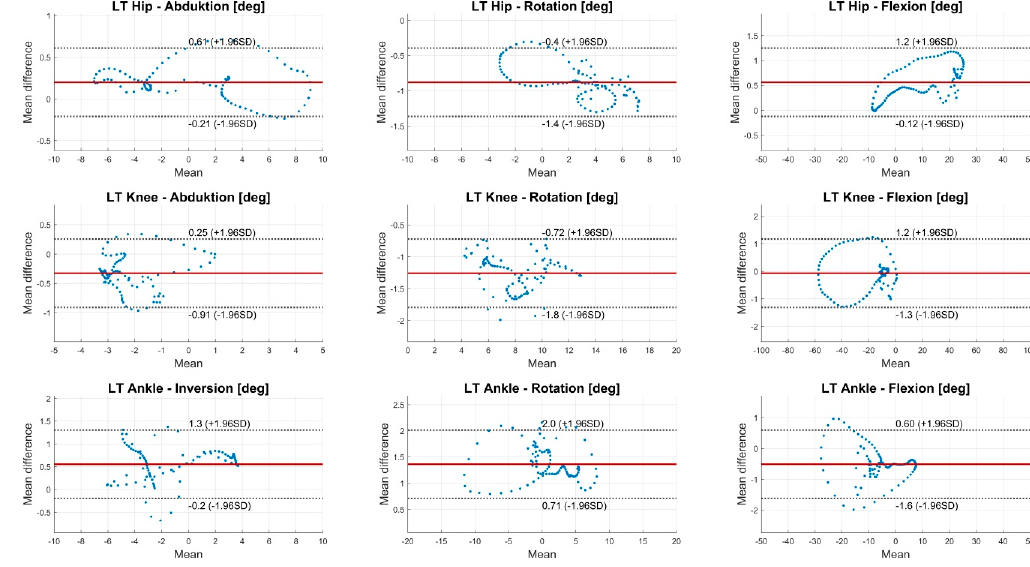
Figure A2. BA diagrams of 3D joint rotations of hip, knee and ankle of the left side for condition 1. The solid line indicates the mean difference. The dashed lines indicate the LoA (95% CI of the mean difference). Sensors 2018 , 18 , x